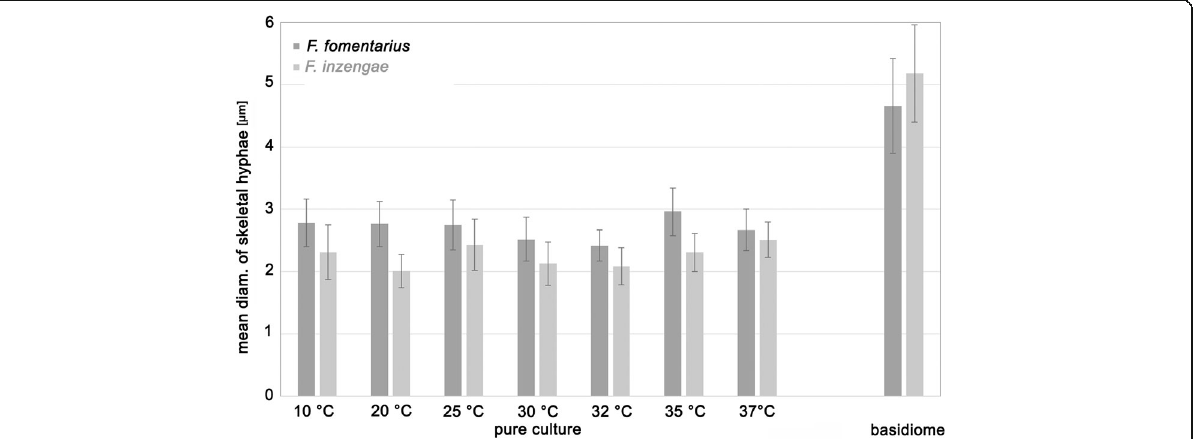
Fig. 5 Diameter of skeletal hyphae in pure culture after 10 d incubation on 3% MEA at different temperatures and in naturally grown basidiomes. Differences between F. fomentarius and F. inzengae are always highly significant (p < 0.0001) with the exception of 37 °C (p < 0.05) ( n = 45 for each temperature; n = 75 for F. fomentarius basidiomes; and n = 90 for F. inzengae